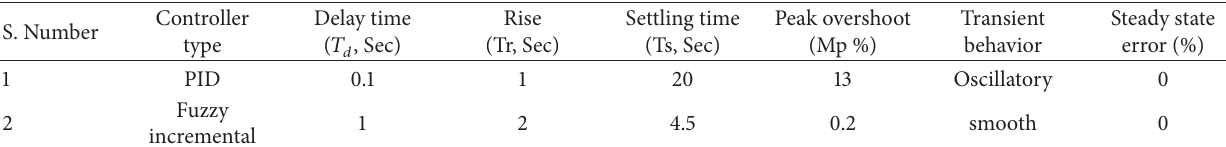
Table 2: Time domain specifications comparison.